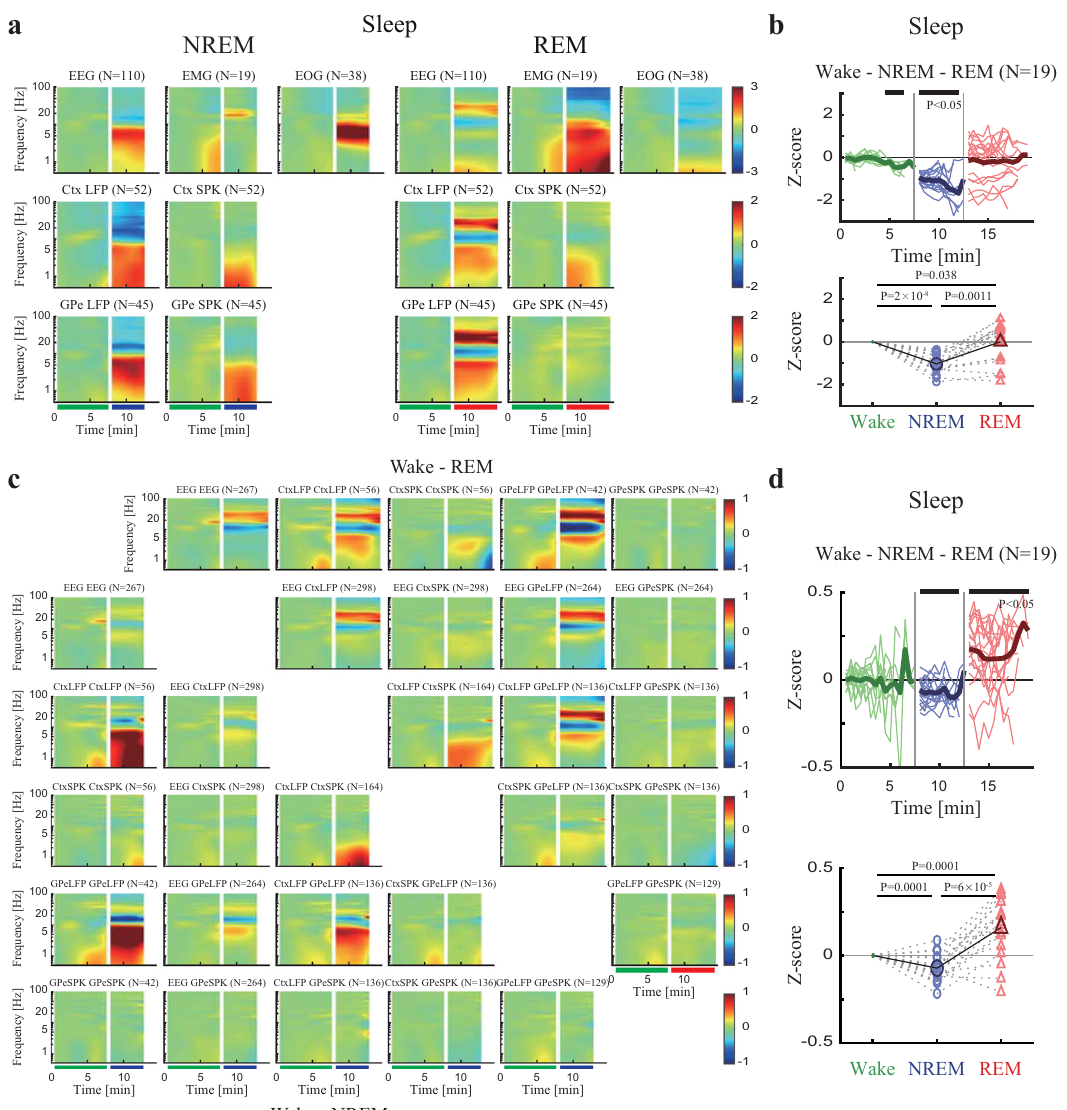
Fig. 4 Polysomnography and neural activity during natural NREM and REM sleep show increased low-frequency power/synchronization and increased high-frequency power/synchronization, respectively. a The normalized power spectrograms of EEG/EMG/EOG (1 st row), Ctx LFP/SPK (2 nd row), and GPe LFP/SPK (3 rd row) during NREM (left) and REM (right). The lower bar represents time periods of wake (green), NREM (blue), and REM (red). Data were averaged over different segments and different time periods are not necessarily sequential. b Upper. The normalized high/low power difference (averaged through all spectrograms within one night) between spectral power at high frequency (12 – 40 Hz) and low frequency (0.5 – 4 Hz) during wake, NREM, and REM. Top black horizontal bar represents a signi fi cant difference compared to wake ( p < 0.05, Kruskal – Wallis test). Lower. The averaged normalized high/low power difference during wake, NREM, and REM. P -value is given, Kruskal – Wallis test. c The normalized magnitude-squared coherograms of all pairs of EEG, Ctx LFP/SPK, and GPe LFP/SPK during NREM (lower left) and REM (upper right). The 1 st row/column shows coherograms within same signal type (e.g., EEG to EEG), other subplots show coherograms between different signal types. The lower bar represents time periods of wake, NREM, and REM. d Same conventions as b for synchronization difference. Number of sites (a), pairs (c), and nights (b, d) is given for both monkeys for each subplot. Abbreviations as in Fig. 1. NREM, nonrapid eye-movement sleep; REM, rapid eye-movement